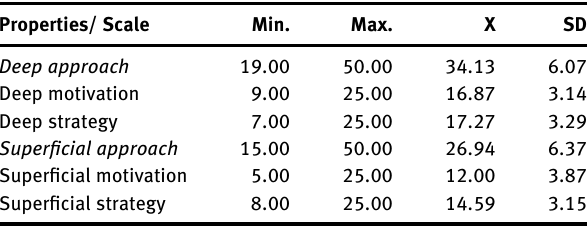
Table  : Arithmetic mean and standard deviations of students ’ learning approach score.